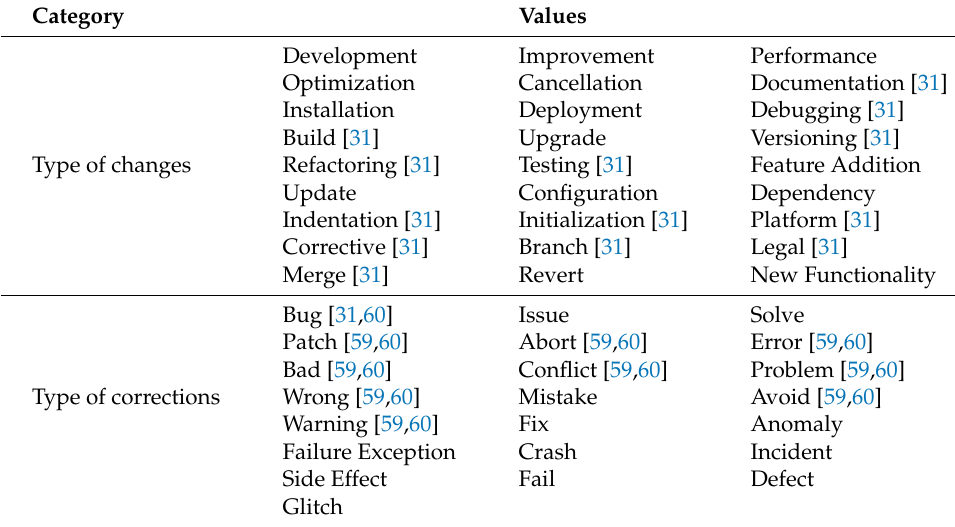
Table 3. Types of changes and corrections.